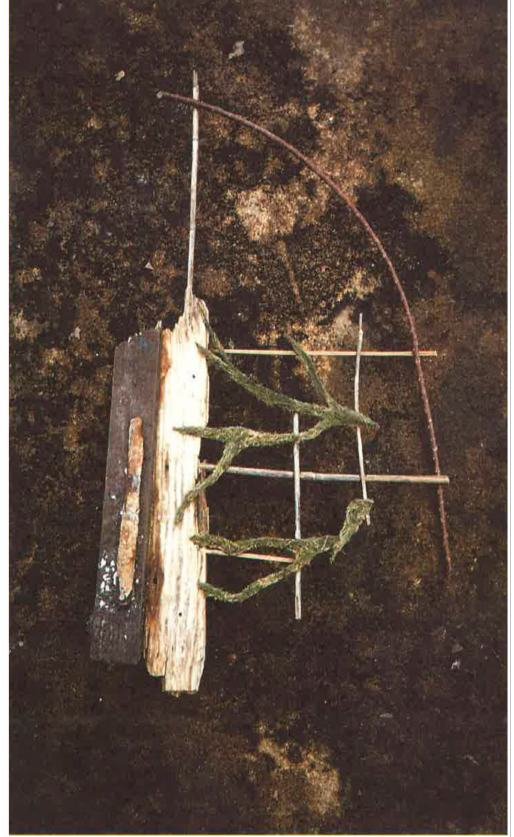
Figure 10. Fieldwork with result on the spot as visualised by materials found on site by Anne-Sophie Perrot [119].